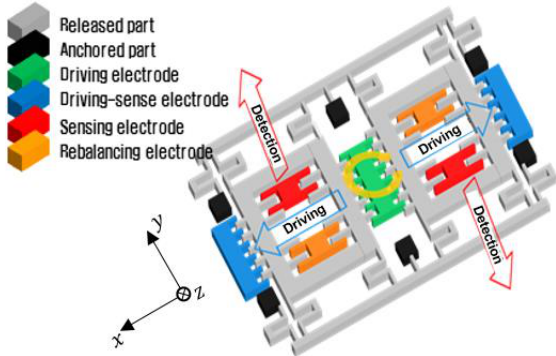
Figure 2. Structure of tuning fork vibratory gyroscope.